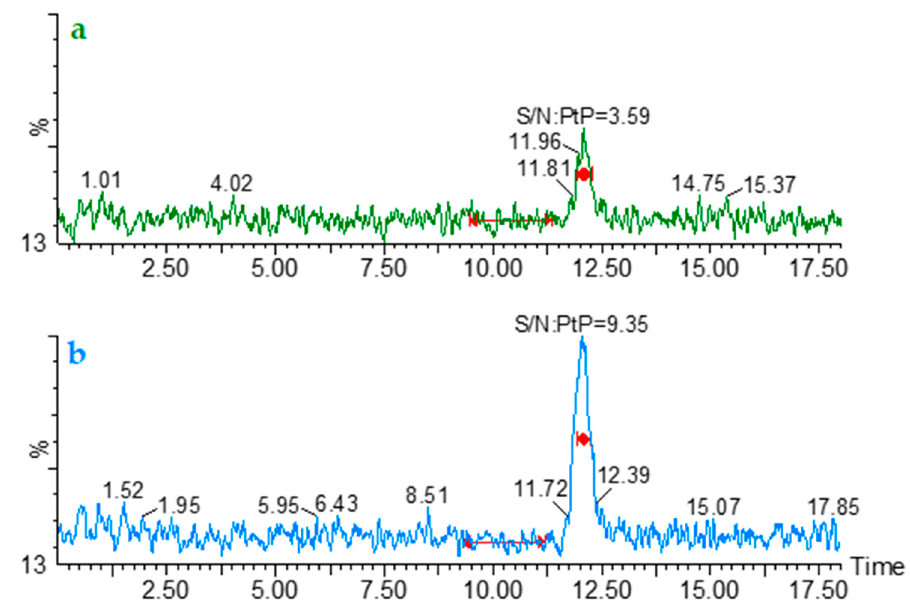
Figure 3. Representative MRM1 chromatograms ( m / z 177 > 116) of ( a ) β -ODAP solution at 10 ng L − 1 (limit of detection—LOD) and ( b ) β -ODAP solution at 25 ng L − 1 (lower limit of quantification—LLOQ). PtP—Peak to Peak.